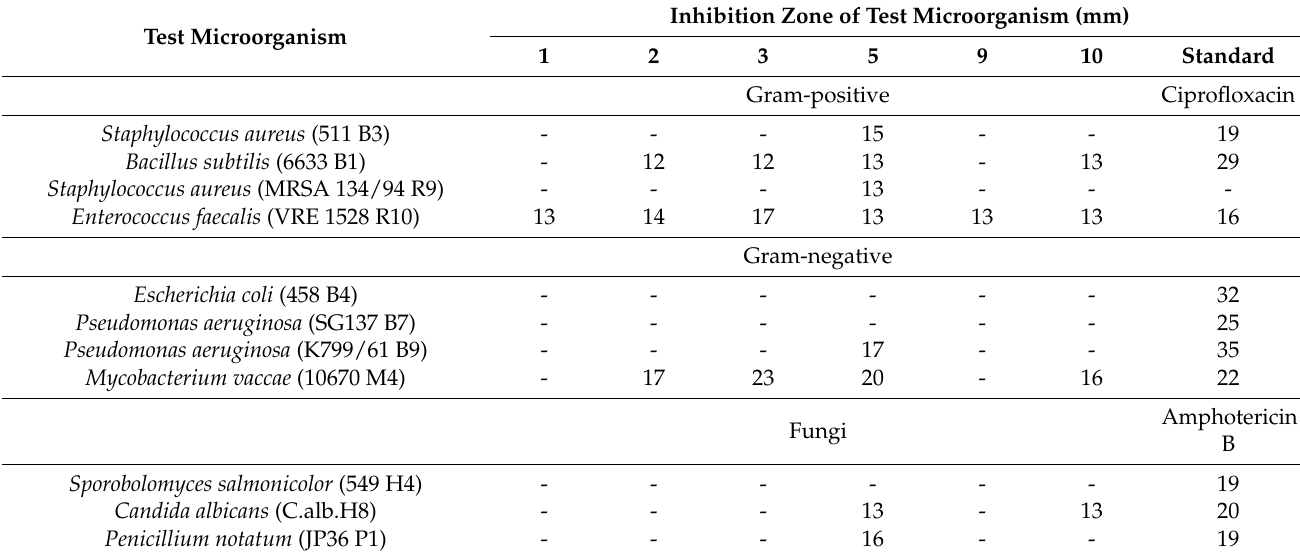
Table 3. Antimicrobial activity using agar diffusion method of some isolated compounds from I. tenuifolia . Test